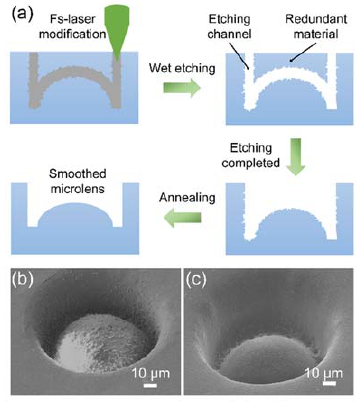
Figure 1. ( a ) Diagram of the mixing process. ( b , c ) SEM images of the microlens before and after the second annealing. second